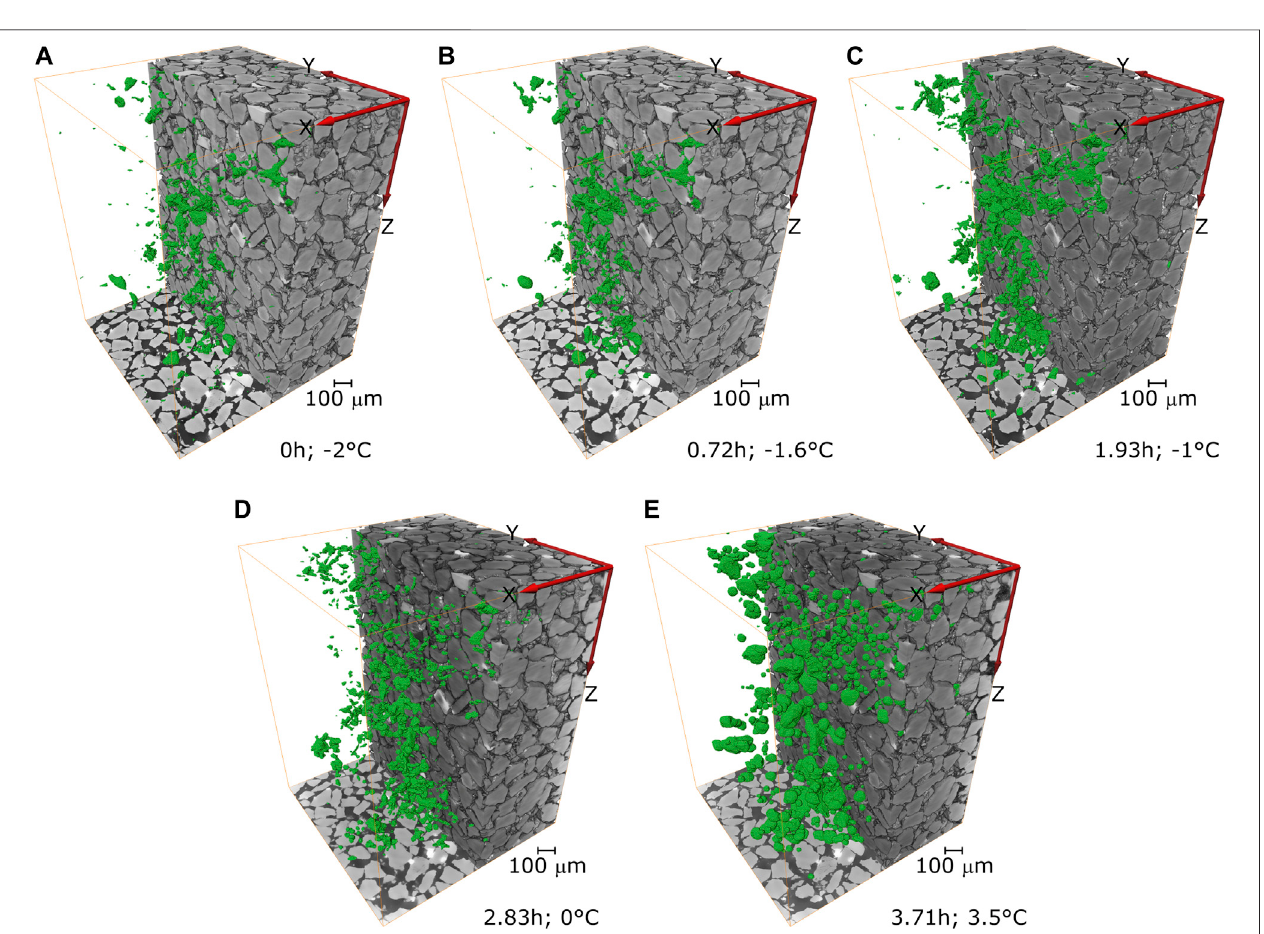
FIGURE4 | Segmented 3D reconstructed CT scanof thespecimen showing the gasbubble distribution within the pore spaceduring hydrate dissociation (A) 0 h, (B) 0.72 h, (C) 1.93 h, (D) 2.83 h, and (E) 3.71 h after initiating the hydrate formation process.